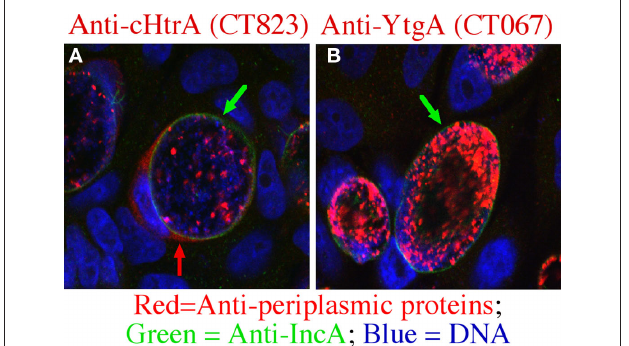
Figure 1 | Chlamydial high temperature requirement protein A (cHtrA) is selectively secreted into host cell cytosol. The Chlamydia trachomatis - infected HeLa cells grown on coverslips were processed at 36 h after infection for an immunofluorescence assay as described previously (Zhong et al., 1997). The samples were triply labeled with mouse anti-cHtrA [CT823 (A) ] or YtgA [CT067 (B) ] antibodies visualized with a goat anti-mouse IgG conjugated with Cy3 (red), a rabbit anti-IncA antibody visualized with a goat anti-rabbit IgG conjugated with Cy2 (green), and the DNA dye Hoechst (blue). The images were acquired using an Olympus confocal microscope. Green arrows indicate inclusion membrane while the red arrow indicates cHtrA secreted into host cell cytosol. Note that only cHtrA but not YtgA was detected outside of the inclusion membrane although both are considered chlamydial periplasmic proteins (Miller et al.,